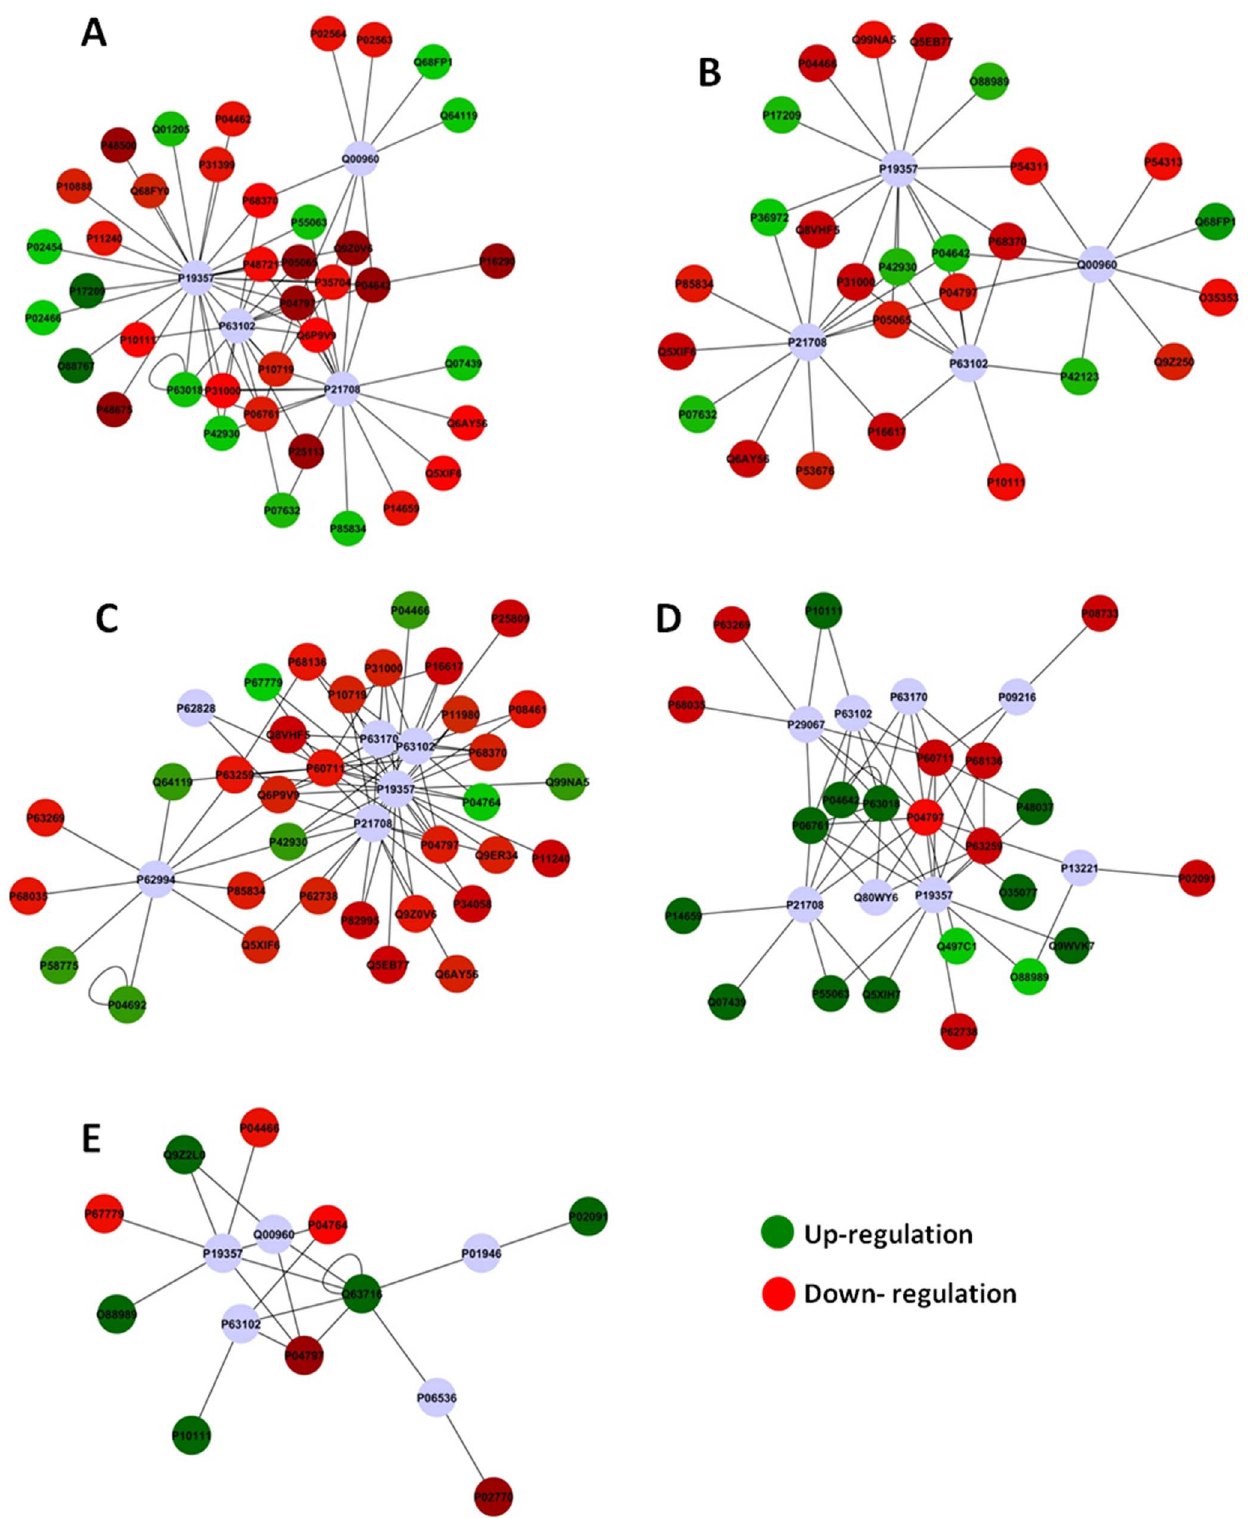
Figure 3. Subnetworks generated by JActiveModules for each comparison – A Group ND0 vs. D0; B Group ND10 vs. D10; C Group ND50 vs. D50; D group D0 vs. D10; E group D0 vs. D50. Red and green nodes indicate protein downregulation and upregulation, respectively, in the first group of each comparison.